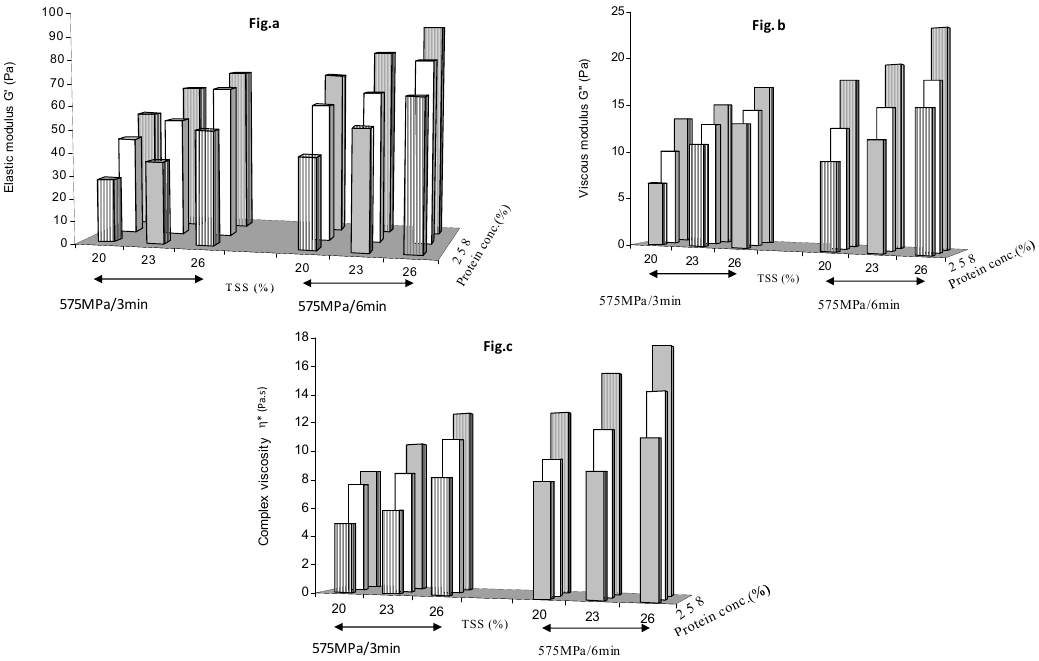
Figure 2. Effect of holding time (3 and 6 min) at 575 MPa on ( a ) elastic modulus ( b ) viscous modulus and ( c ) complex viscosity of protein added mango puree.